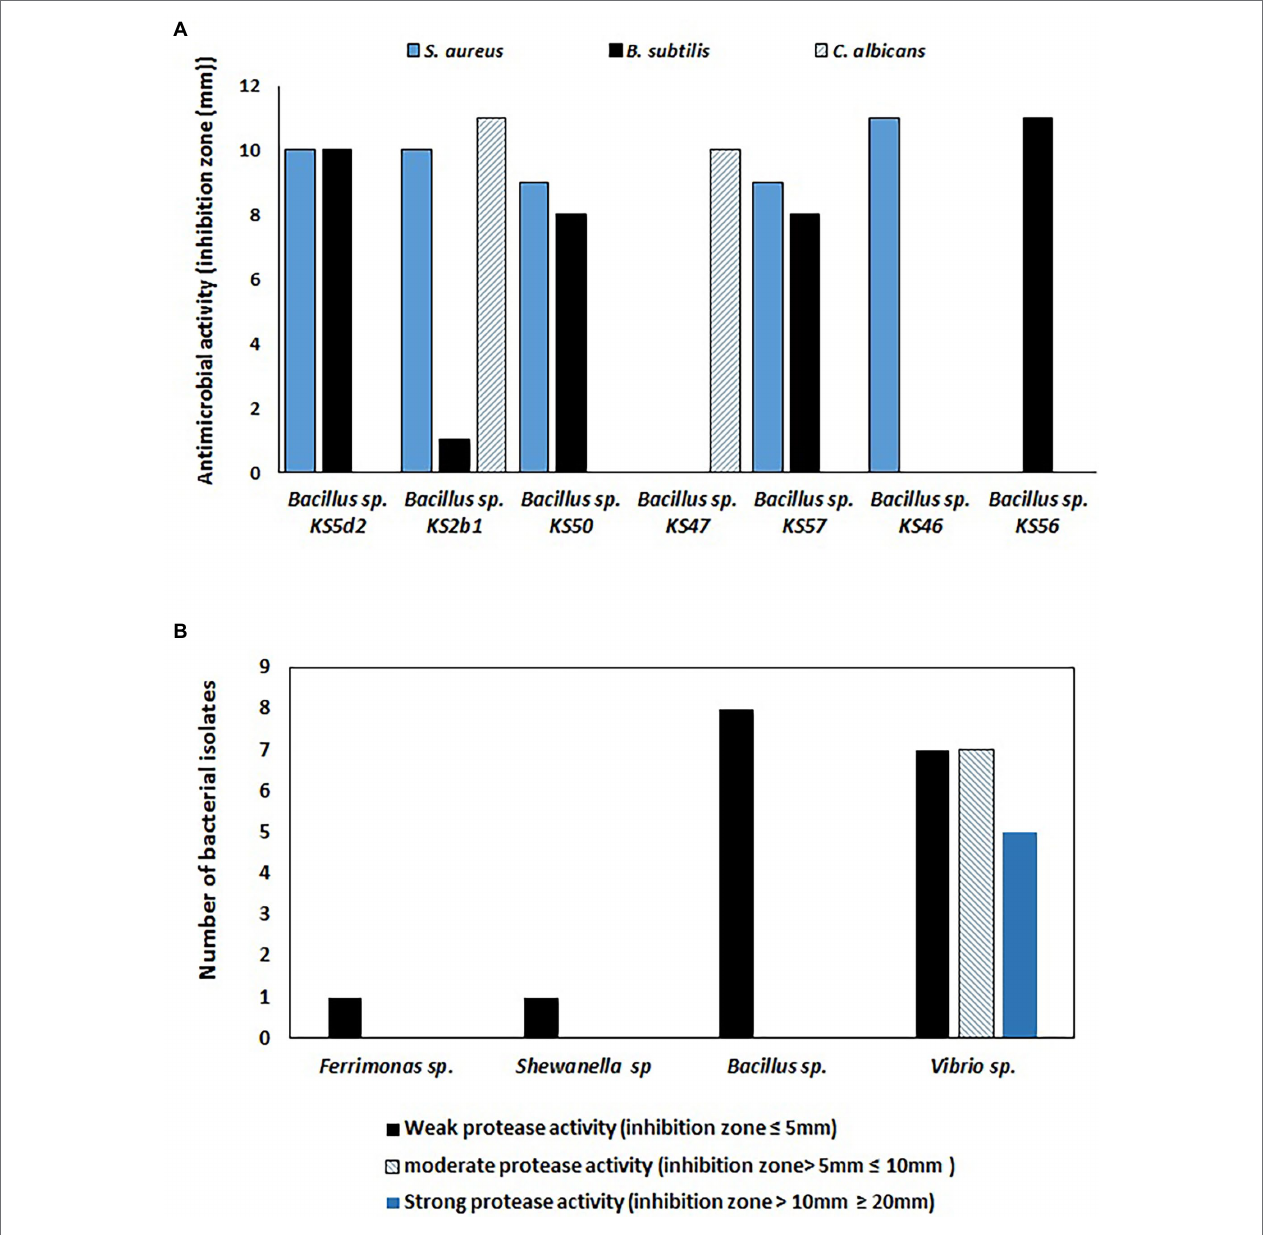
FIGURE 4 | (A) Antimicrobial activities of sponge-associated bacterial isolates against three bacterial cultures (i.e., Bacillus subtilis , Staphylococcus aureus , and Candida albicans ). Weak antimicrobial activity (inhibition zone ≤ 10 mm) and moderate antimicrobial activity (inhibition zone ≥ 10 mm), (B) Number of bacterial isolates with positive protease